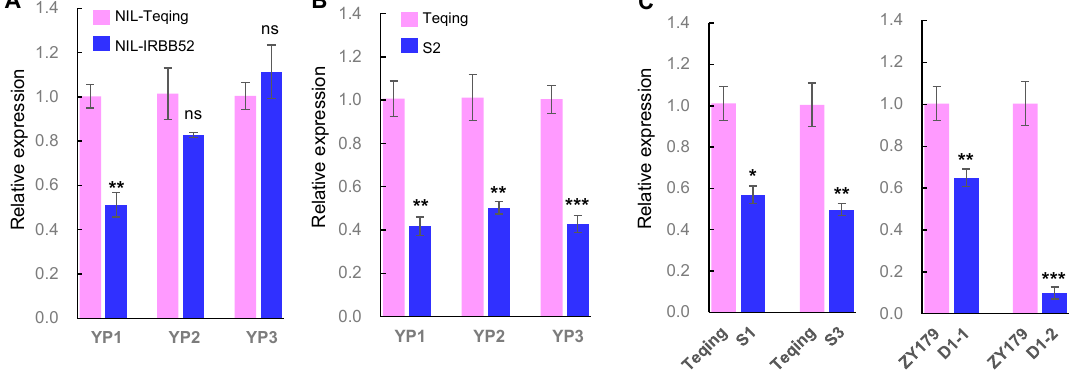
Figure 4. Relative expression of OsMADS56 in young panicles of near-isogenic lines (NILs) and OsMADS56 knock-out mutants determined by qRT-PCR. ( A , B ) Relative expression in three periods of the young panicles. YP1: panicles of 1–5 cm in length; YP2: panicles of 6–10 cm in length; YP3: panicles of 11–15 cm in length. NIL-Teqing and NIL-IRBB52 are near-isogenic lines carrying Teqing and IRBB52 alleles of OsMADS56 , respectively. S2 is a mutant in the Teqing background. ( C ) Relative expression of four mutants in panicles at YP3. S1 and S3 are two mutants in the Teqing background. D1-1 and D1-2 are two mutants in the ZY179 background. Values are given as the mean ± SEM ( n = 3). Significant difference was detected by using Student’s t- test. * p < 0.05, ** p < 0.01, *** p < 0.001, ns: not significant.